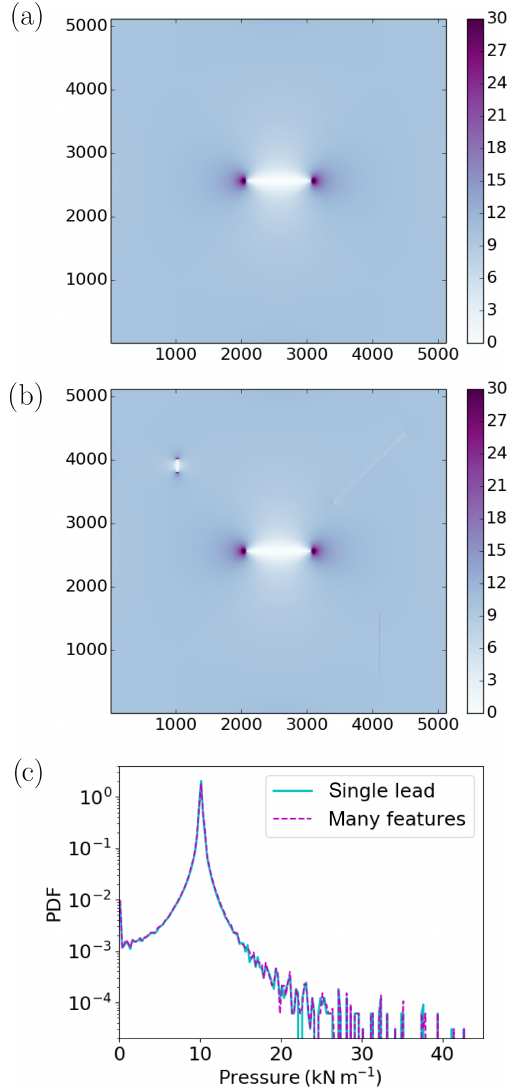
Figure 4. Pressure (kNm − 1 ) field for a thickness field of 2m every- where except a 1km long, 10m wide horizontal lead in the middle of the domain ( a ; referred to as “single lead”). Pressure (kNm − 1 ) field for a thickness field of 2m everywhere except a 1km long, 10m wide horizontal lead in the middle of the domain, a diagonal refrozen lead ( h = 0.5m), a smaller lead in the northwestern part of the domain and a 1km ridge ( h = 5m in center, 2.5m on each side) in the southeastern part of the domain ( b , referred to as “many fea- tures”). For both experiments (cid:49)x = 10m, and the normal stresses at the boundaries are − 10kNm − 1 . c PDFs of the pressure for the “single lead” experiment (cyan) and the “many features” experi- ment (dashed